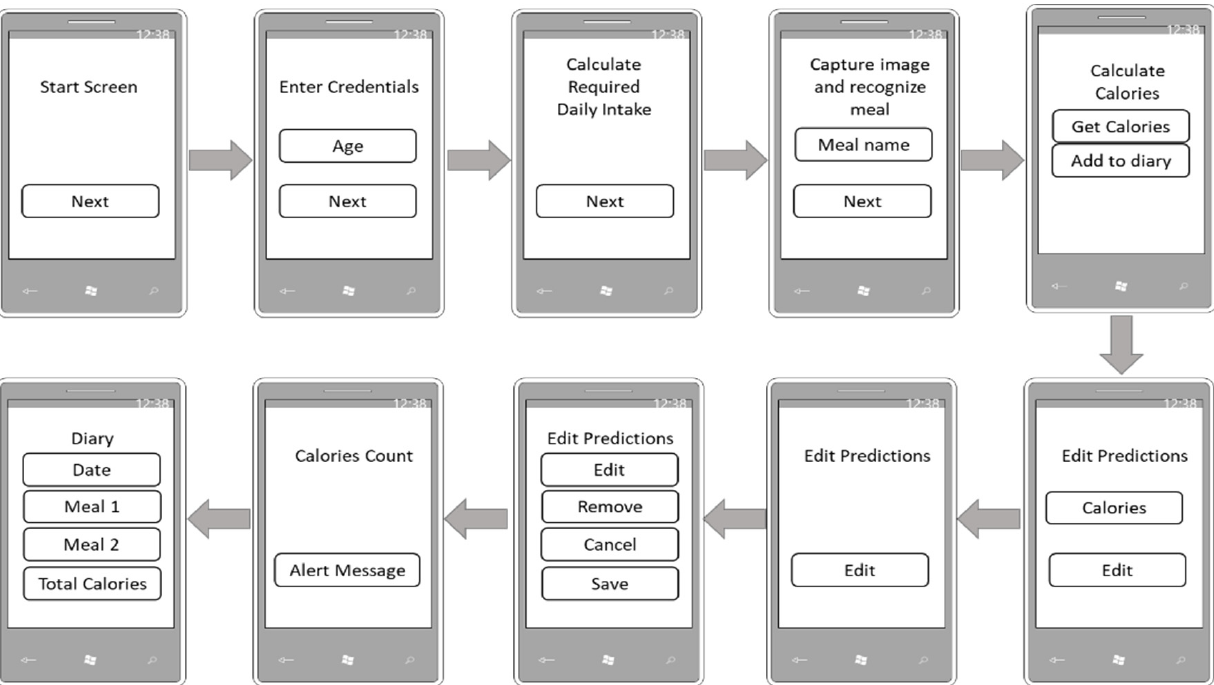
Figure 3. Smart Diet Diary storyboard.